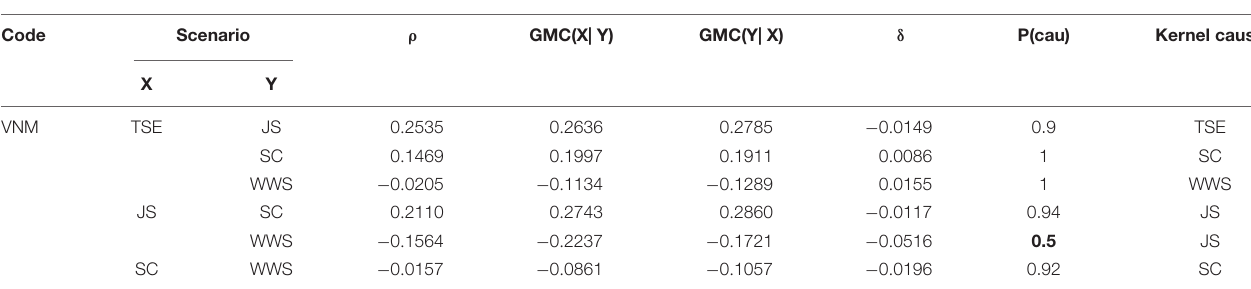
TABLE 11 | Summary of GMC for